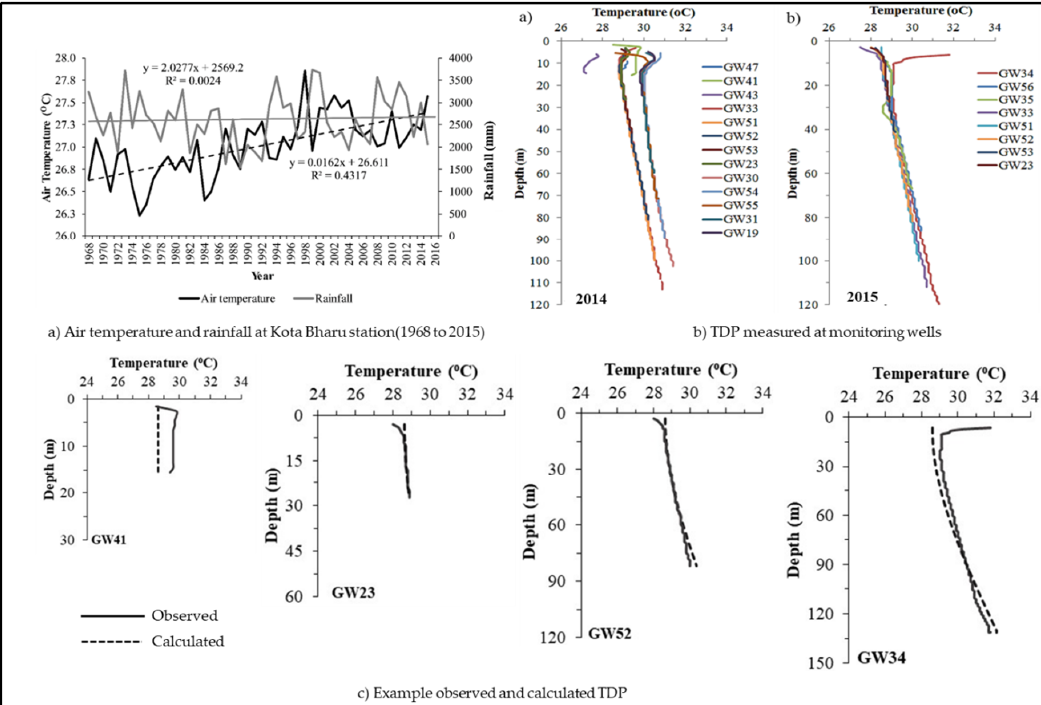
Figure 4. ( a ) Mean annual air temperature and rainfall at Kota Bharu station; ( b ) measured temperature – depth profiles (TDP) during sampling campaign; and ( c ) examples observed and calculated TDP.